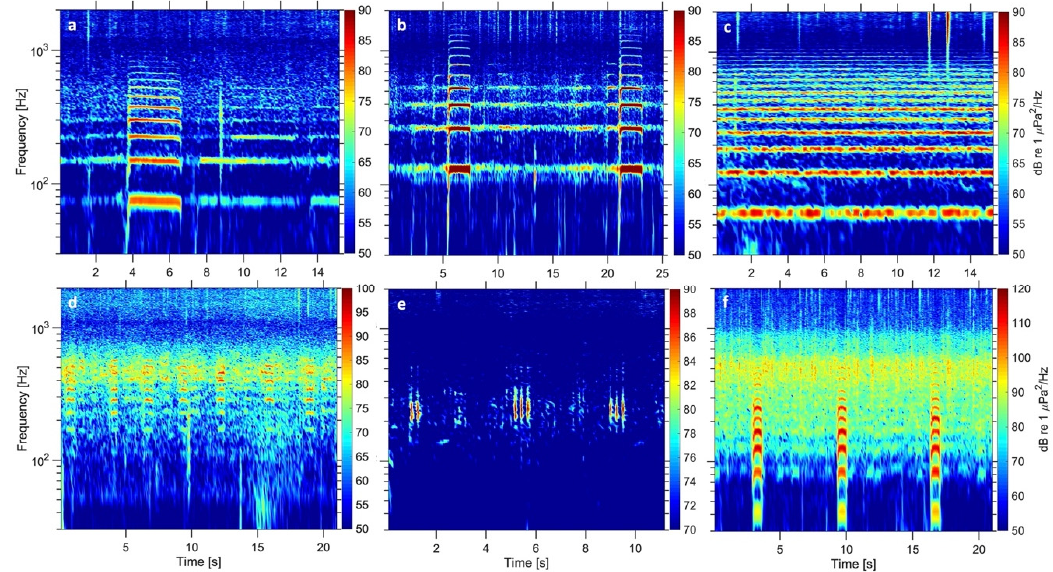
Figure 2. Spectrograms of fish choruses I ( a ), II ( b ), III ( c ), IV ( d ), V ( e ), and VI ( f ). Spectrogram of chorus VI also contains chorus IV in the background. Note that the frequency range is the same for all subfigures, while the colour bar differs in range for subfigures d and f.